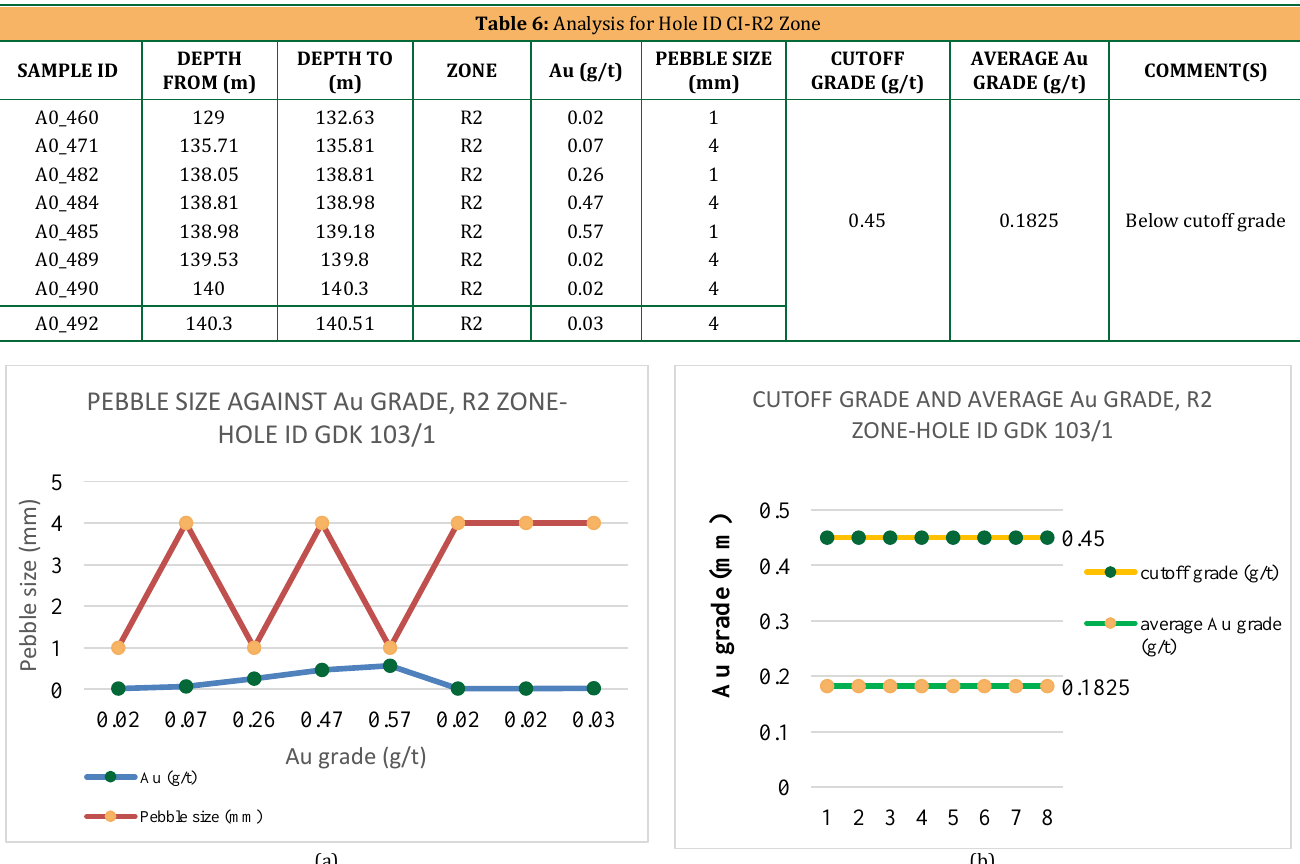
Figure 5: (a) Pebble size against Au grade, R2 Zone-Hole ID GDK 103/1; (b) Cutoff grade and average Au grade, R2 Zone-Hole ID GDK